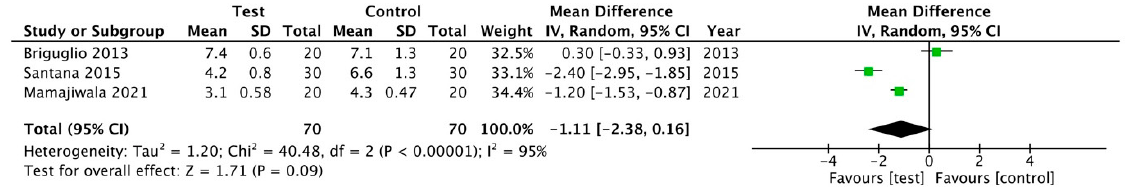
Figure 2. Forest plot for PD reduction after 12 months.